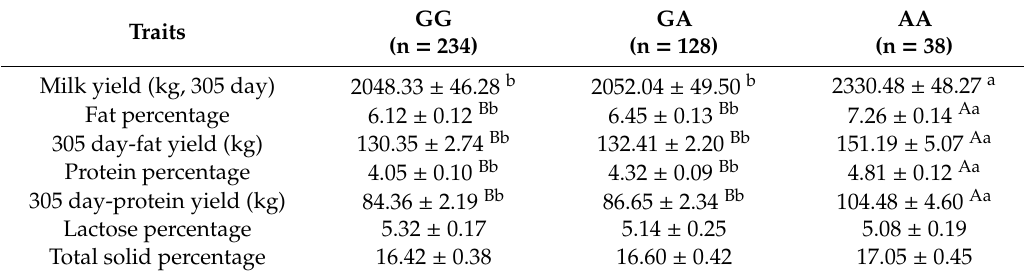
Table 3. Association between individual c.380G > A SNP and milk yield and quality traits.